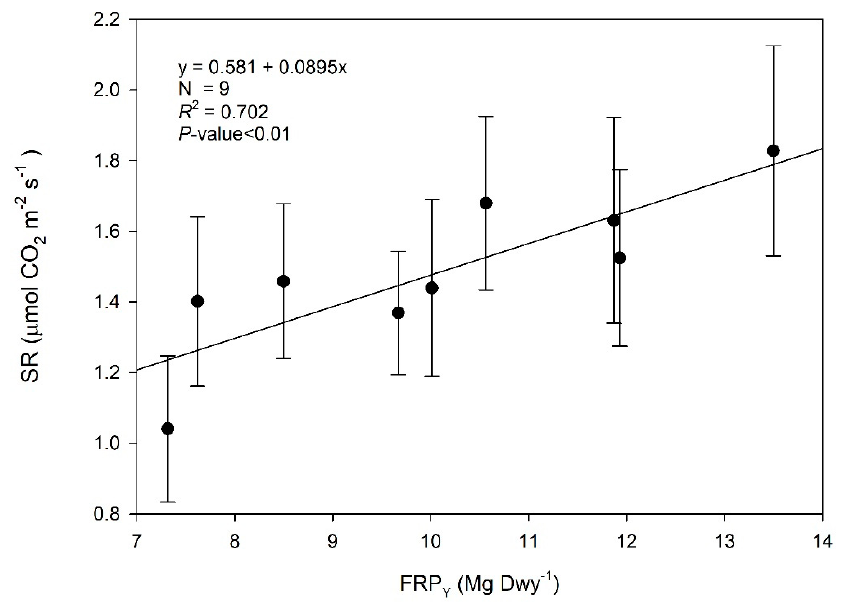
Figure 3. Relationship between annual fine root production (FRP Y ) and mean soil CO 2 efflux (SR). Each point is a different sampling plot, and error bars represent standard deviation.